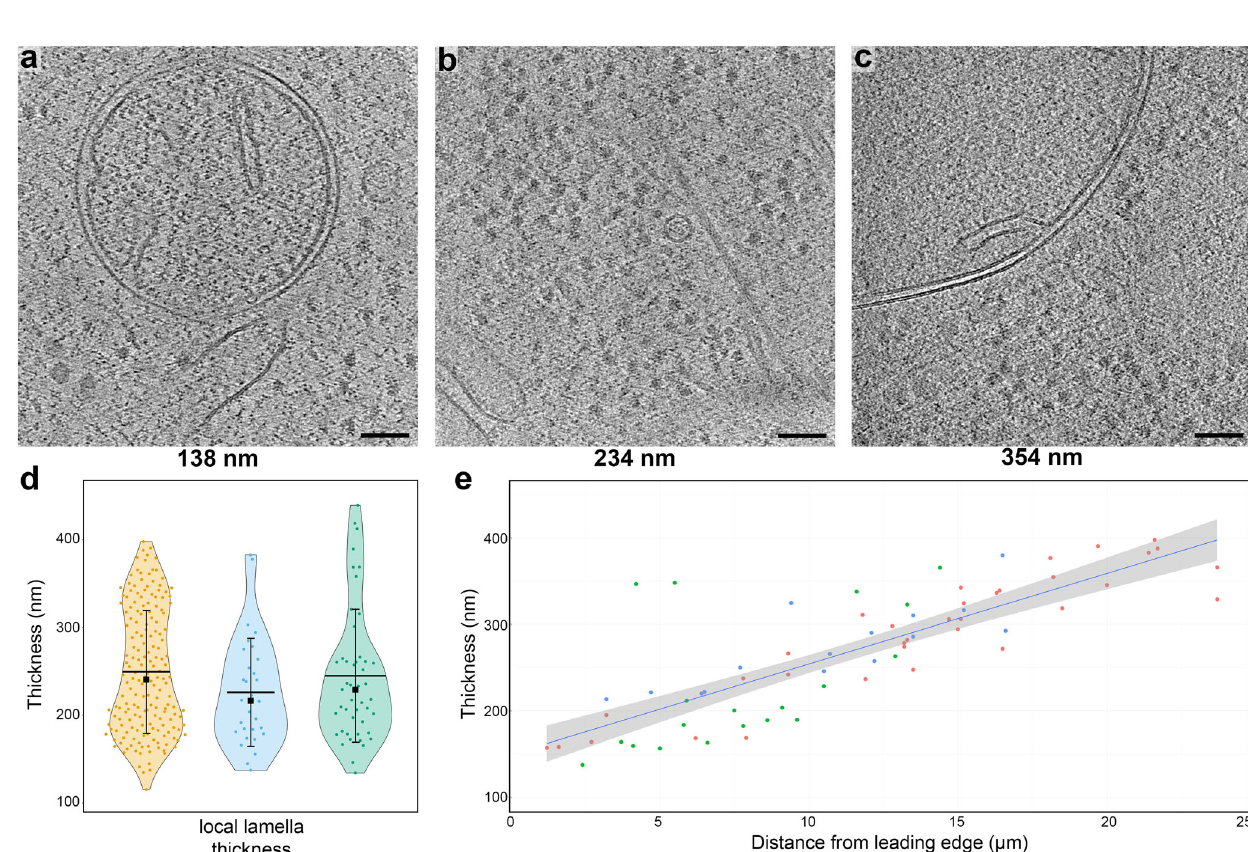
Fig. 2 | Plasma-milling produces lamellae with a range of thicknesses that exhibit usable sub-cellular tomographic data. a – c representative tomographic slices of tomograms recorded on lamellae with different thicknesses (indicated below each panel). Scale bars: 100nm. d Violin plots showing the distribution of tomogram thickness as determined in the reconstructed tomograms, in three independent argon datasets prepared with the same milling conditions. Orange (left):meanSD;250nm±70, n =180tomograms(from17lamellae).Blue(middle): mean SD; 227nm ± 62, n =30 tomograms (from 11 lamellae). Green (right): mean SD; 245nm ± 76, n =47 tomograms (from 16 lamellae). Horizontal black bars